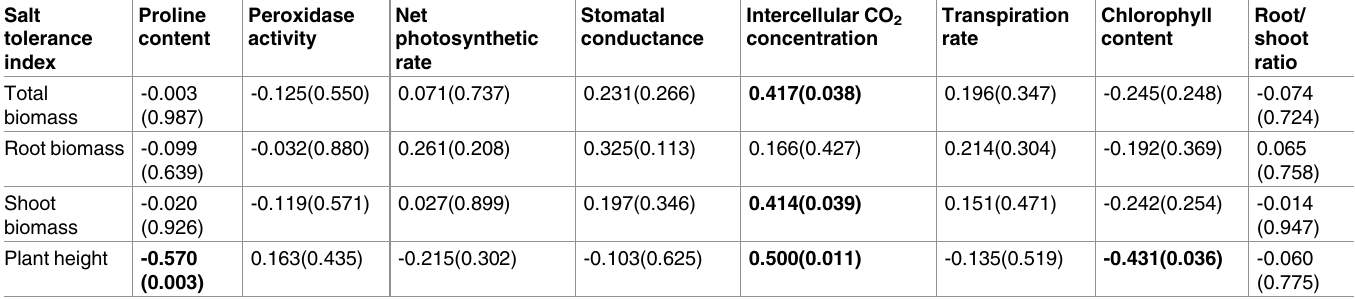
Table 4. Pearson’s correlation between the plasticity index of physiological traits and the salt tolerance index. The p values are listed in parenthe- ses. The figures in boldindicate